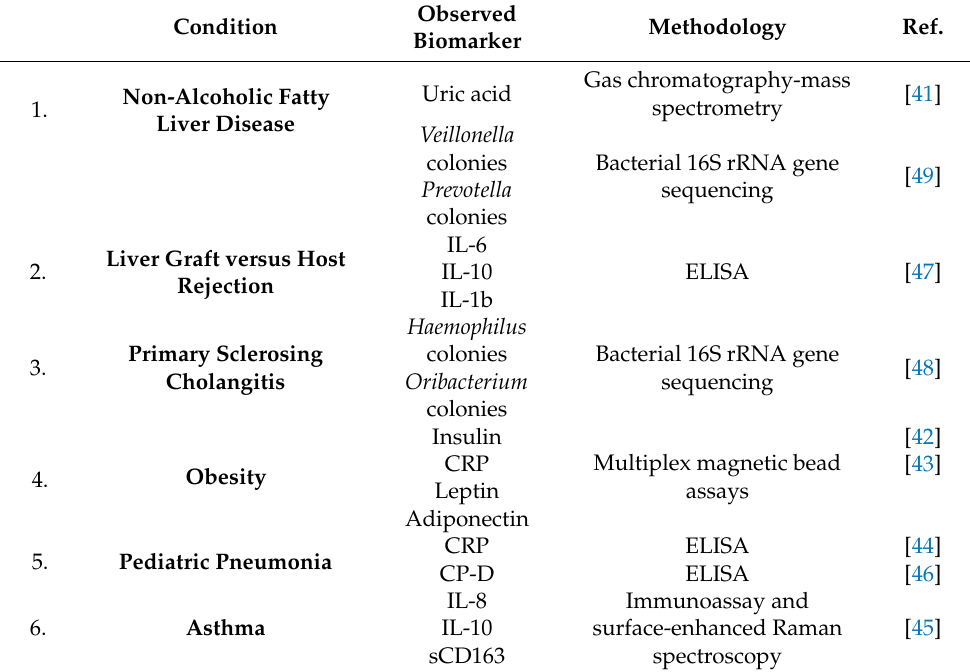
Table 4. Common metabolic, gastrointestinal, and pulmonary conditions and their respective biomarkers. Observed Condition Methodology Biomarker